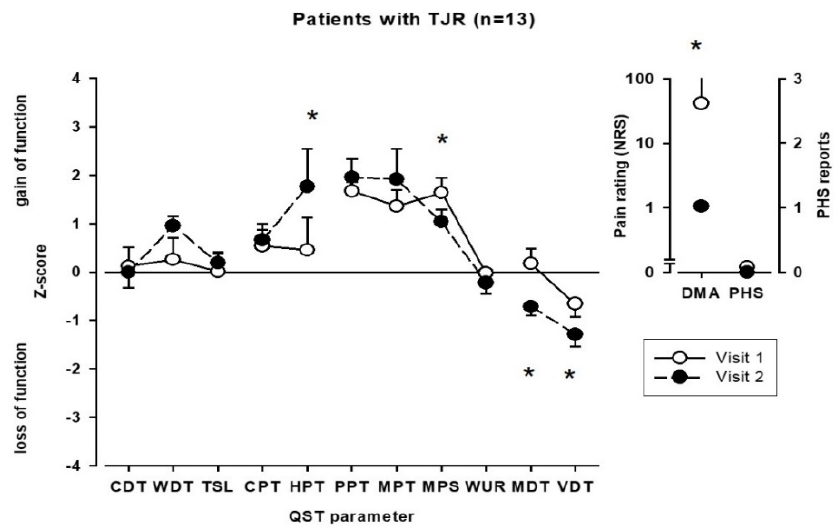
Figure 2. Somatosensory profiles of patients with TJR at baseline (visit 1) and follow-up visit (visit 2). CDT, cold detection threshold; WDT, warm detection threshold; TSL, thermal sensory limen; CPT, cold pain threshold; HPT, heat pain threshold; PPT, pressure pain threshold; MPT, mechanical pain threshold; MPS, mechanical pain sensitivity; WUR, wind-up ratio; MDT, mechanical detection threshold; VDT, vibration detection threshold; DMA, dynamic mechanical allodynia; PHS, paradoxical heat sensation; TJR, total joint replacement; * p < 0.05, patients with TJR compared for visit 1 and visit 2.